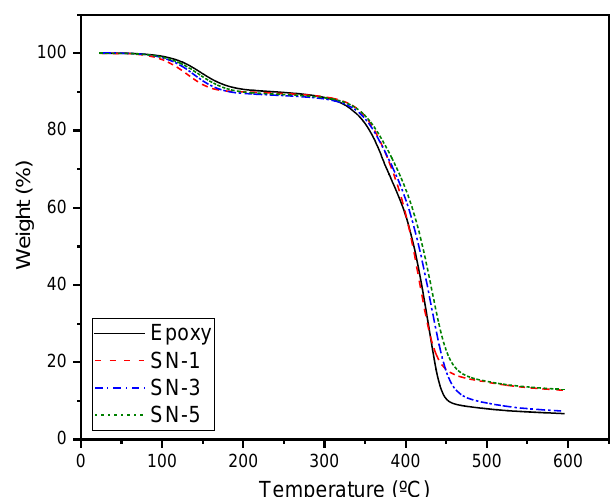
Figure 2. Thermogravimetric analysis (TGA) curves of epoxy and silica nanoparticles modified epoxy coatings. Table 3. Degradation temperatures for unmodified and SiO 2 nanoparticle (SNP)-modified epoxy formulations.